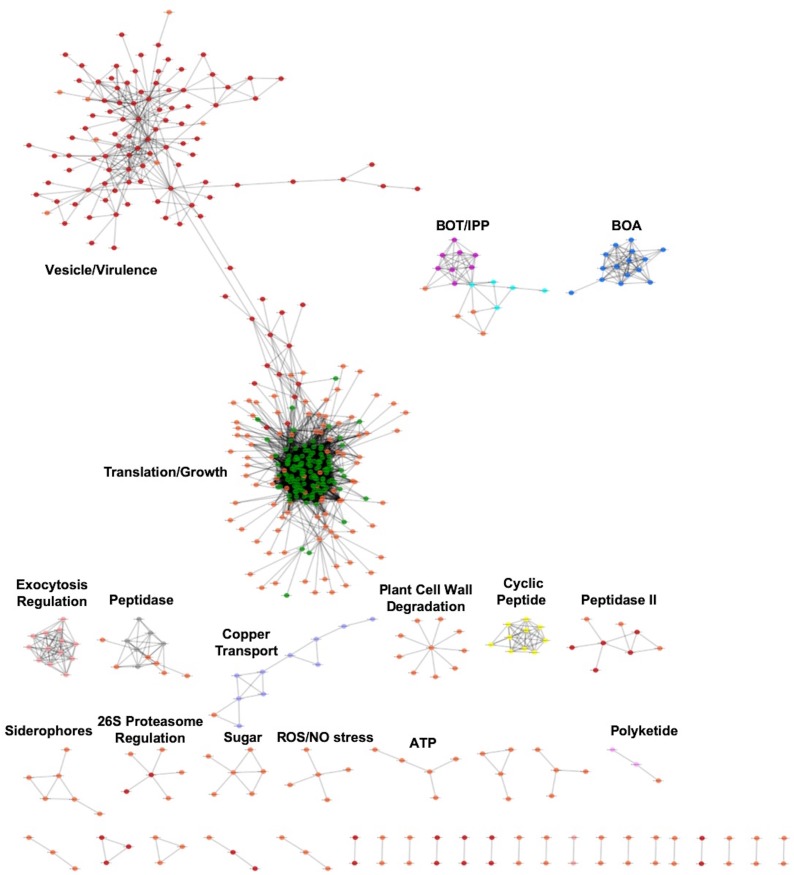
Gene co-expression networks identified from B. cinerea transcriptomic responses to Arabidopsis jasmonate-compromised immunity.B. cinerea gene co-expression networks (GCNs) were identified from 96 B. cinerea isolates infecting on Arabidopsis jasmonate insensitive mutant coi1-1. The similarity matrix is computed using Spearman’s rank correlation coefficient. All co-expressed gene pairs with correlation greater than 0.8 were shown. Nodes with different colors represent B. cinerea genes condensed in GCNs with different biological functions. Nodes were marked with same color as under Arabidopsis wild-type Col-0 background. Nodes specificaly condenced in GCNs under Arabidopsis mutant coi1-1 background are marked with orange color. Edges represent the Spearman’s rank correlation coefficients between gene pairs. GCNs were ordered as number of nodes within each network. GCNs were named after their biological functions, which were determined by hub and bottleneck genes within each network: vesicle/virulence (red/orange), translation/growth (green/orange), botrydial/isopentenyl pyrophosphate (BOT/IPP, blue/turquoise/orange), botcinic acid (BOA, blue), exocytosis regulation (pink), peptidase (gray/orange), copper transport (slate blue/orange), plant cell wall degradation (orange), cyclic peptide (yellow), peptidase II (red/orange), siderophores (orange), 26S proteasome regulated protein degradation (red/orange), sugar, ROS/NO stress (orange), ATP (orange), polyketide (violet/orange).